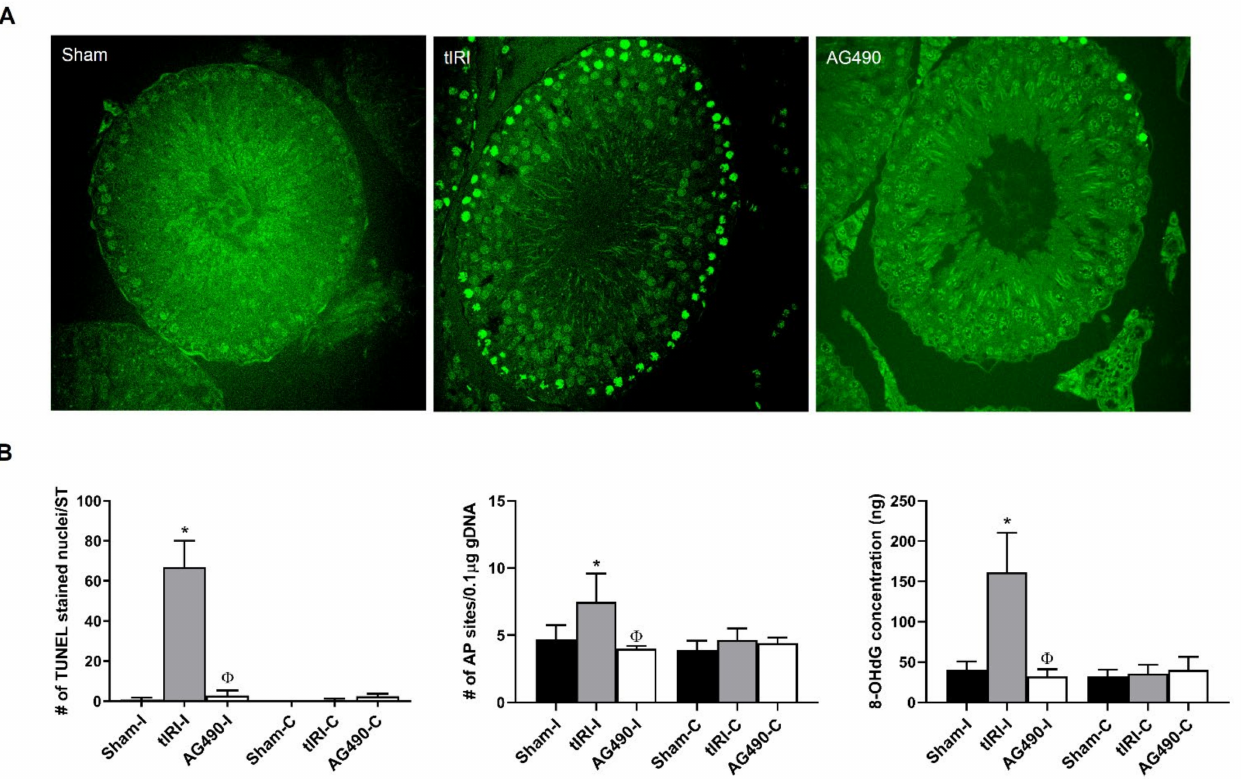
Figure 3. JAK2 inhibition prevents tIRI-induced oxidative DNA damage. ( A ) Representative images of TUNEL assay using fluorescently labeled 3 (cid:48) dUTP of ipsilateral testes at 40x magnification. The tIRI histological sections had a significantly higher number of TUNEL-positive stained nuclei compared to sham. The AG490-treated tissue sections showed a diminished number of TUNEL-positive stained nuclei similar to sham. ( B ) A graph representation of oxidative DNA damage markers: DNA strand breaks (TUNEL), AP sites quantification and 8-OHdG concentration. Ipsilateral testes of tIRI group showed higher number of DNA strand breaks (* p < 0.0001, Φ p < 0.0001), number of AP sites (* p = 0.0005, Φ p < 0.0001) and 8-OHdG concentration ( * p = 0.0005, Φ p < 0.0001) compared to sham and AG490-treated groups, respectively. The contralateral testes in all groups showed no significant difference ( p > 0.05). Data are presented as mean ± SD ( n = 6/group). * tIRI compared to sham and Φ AG490 compared to tIRI. I = Ipsilateral and C = Contralateral.